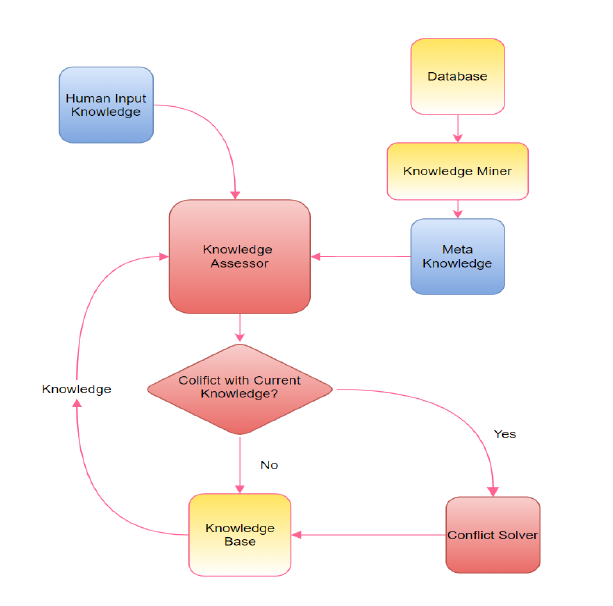
Figure 3. Knowledge system structure for lifelong machine